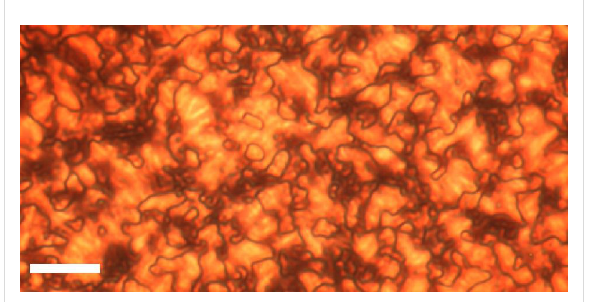
thermally unstable hybrids, due to delamination and/or surface reorganisation of the ligands. As reported for the related system above [69], both the hexane- and dodecanethiol coated hybrids Au@C 6 /13 and Au@C 12 /13 exhibited mesogenic behaviour,